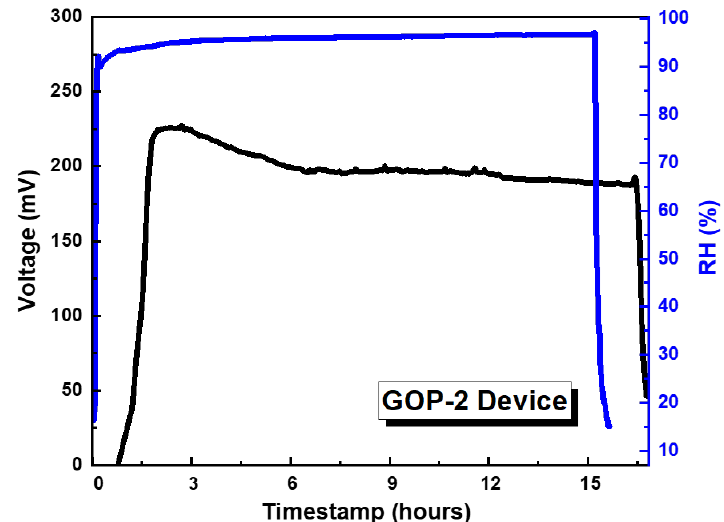
Figure 7. Evaluation of V o stability under prolonged exposure to high RH conditions (95%) for GOP-2 device.